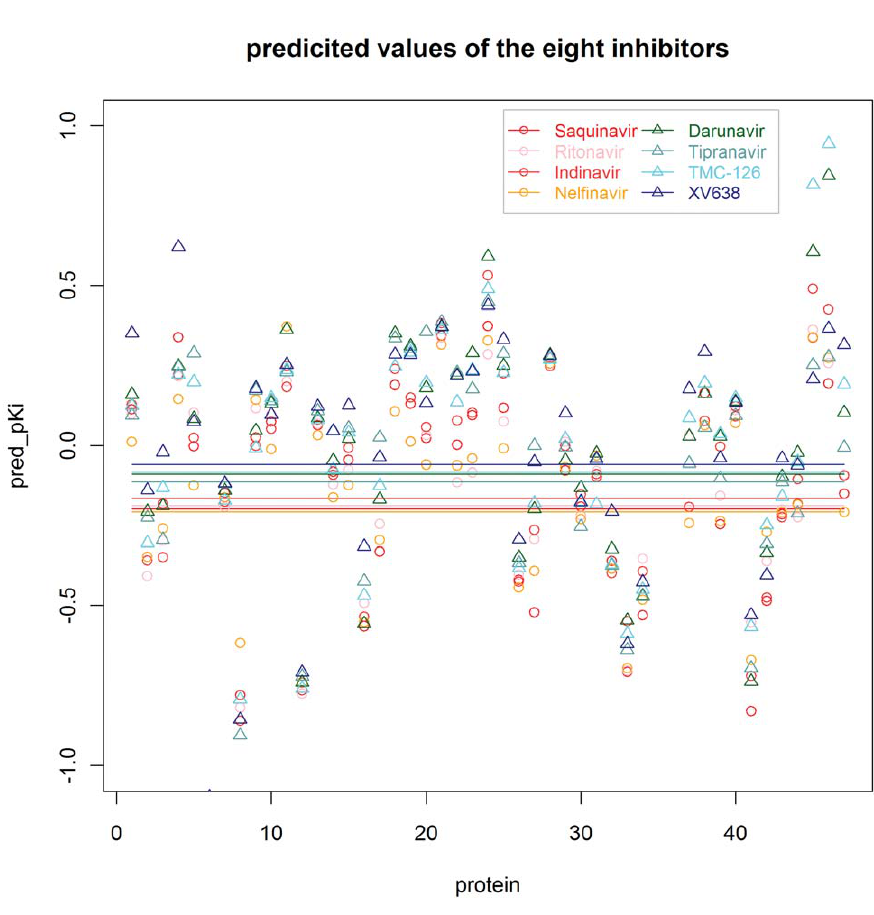
Figure 3. General framework for our proteochemometric modeling.